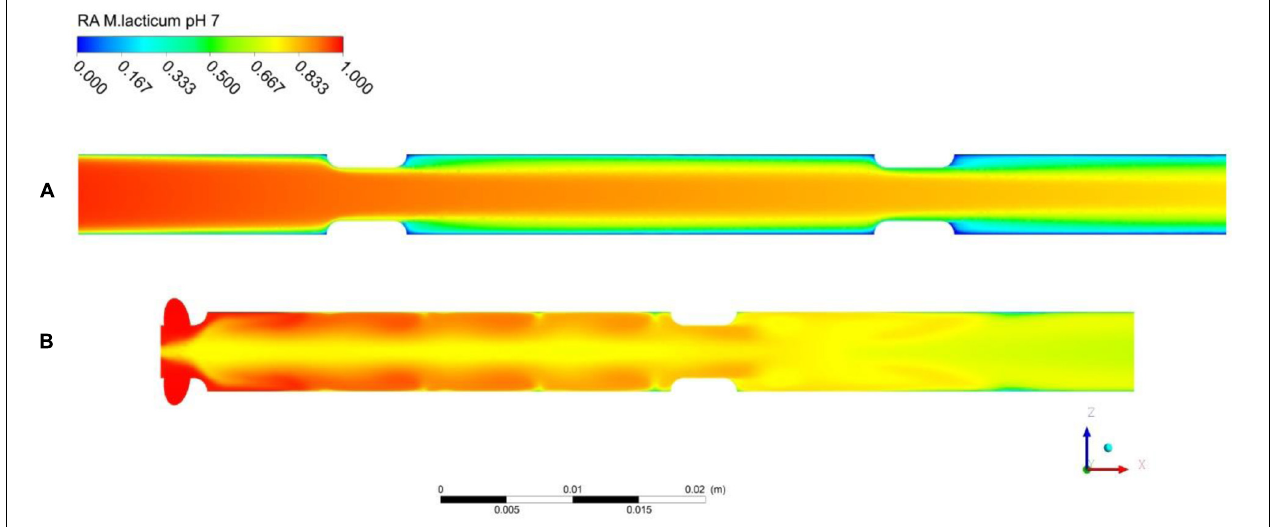
FIGURE 8 | Simulated total inactivation based on residual activity (RA) of M. lacticum at pH 7 inside the co-linear (A) and vortex (B) treatment chamber configurations. Assumed processing conditions: ˙ m = 7 kg / h, T in = 50 ◦ C, E avg = 32 kV / cm, f p = 100 Hz, τ p = 3 µ s. Note that microbial inactivation is expressed in linear